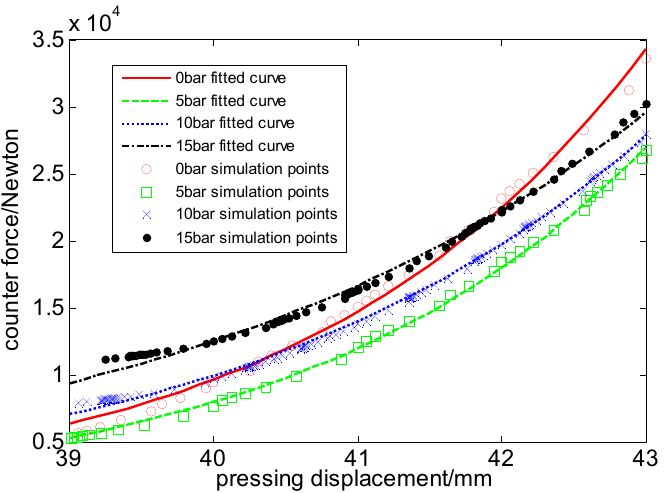
Figure 17. The influence of the pressing displacement on the maximum principal strain ( a ) and the maximum Von Mises stress ( b ) in the model. Table 3. Mathematical forms and goodness of fitting of the dependency of the in contact area on the pressing displacement.